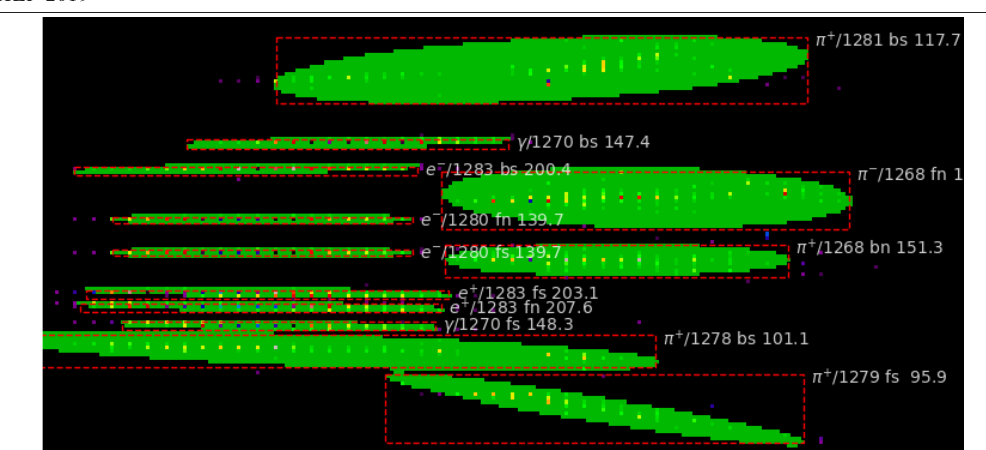
Figure 3. Illustration of a synthetic event (image) used for the training. The di ff erent particles coming from di ff erent events of one simulation in which we can compute all GT information (used for the train- ing process) are overlaid. The particle labels in the above figure have the following form: particle type, source event ID, “b / f” for backward / forward detector, “s / n” with a mirroring symmetry or not, and the particle total energy. The pixel colors represent the energy deposits in the HGCAL detector (projected on 256x256-sized histograms). The pixel alignment shows the di ff erent detector layer positions. In green , the masks (ellipses) obtain from a principal component analysis gathering 90 % of particle en- ergy and in red , the bounding boxes extracted from the masks / ellipses. All these data: class, bounding box and mask, establish the GT for the learning